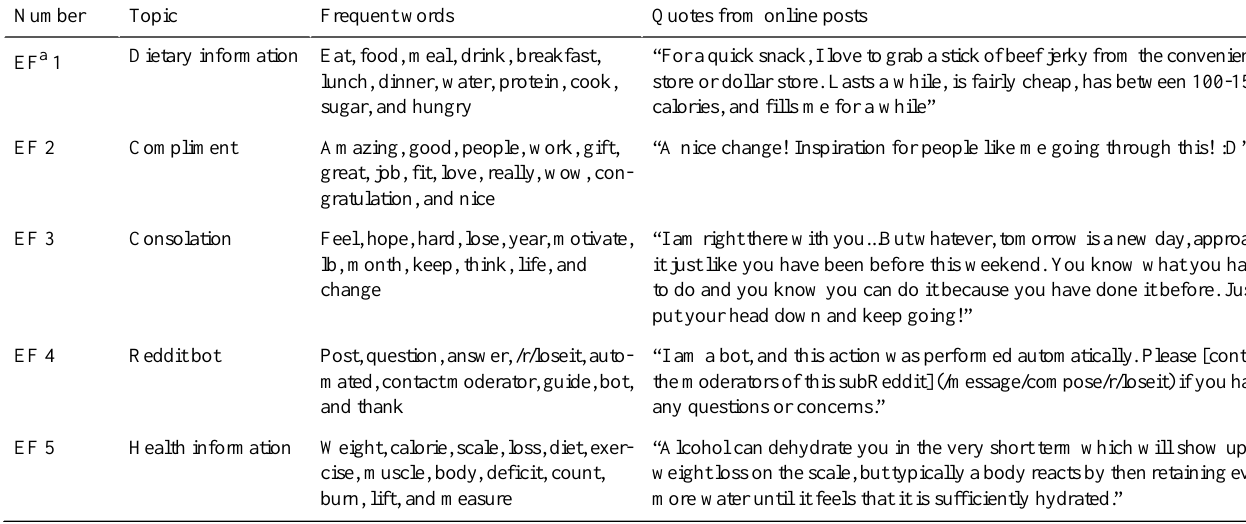
Table 4. Topics of feedback.